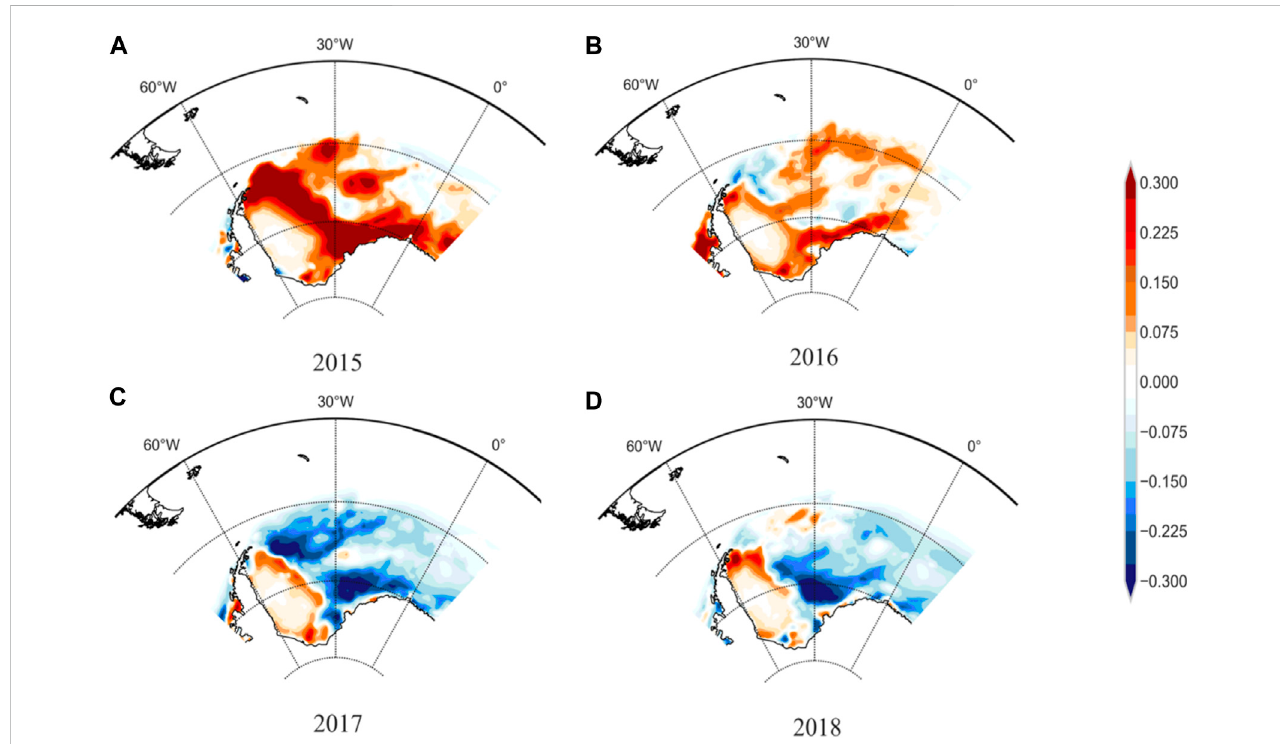
FIGURE 3 Anomaly of Weddell Sea SIC in austral summer of 2015 (A) , 2016 (B) , 2017 (C) , and 2018 (D) based on the climatology of 1979 – 2020 (unit: